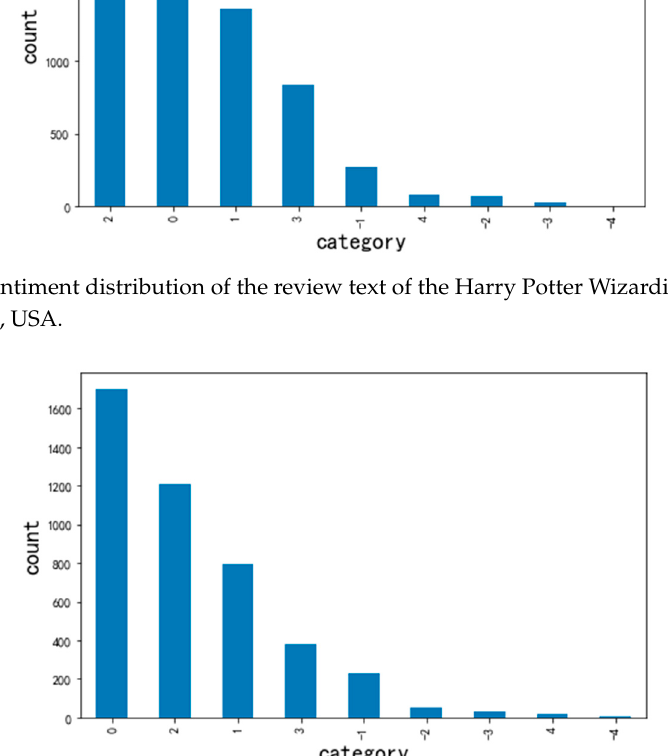
Figure 10. The sentiment distribution of the review text of Sydney Opera House, Australia. (2) Sampling experiment of unbalanced data From the analysis presented in the previous section, we can see that the sentiment distribution of online travel review texts is very uneven. In fact, this is a typical unbalanced dataset. For unbalanced datasets, machine learning classifiers will tend to incorrectly divide new samples into categories with more samples, resulting in classification errors [69]. The methods used to process unbalanced datasets are mainly divided into undersampling, oversampling, and improved methods [70]. This study used Python to implement two types of sampling methods. Our experimental results demonstrate that, due to the extremely uneven sentiment distribution of the experimental dataset